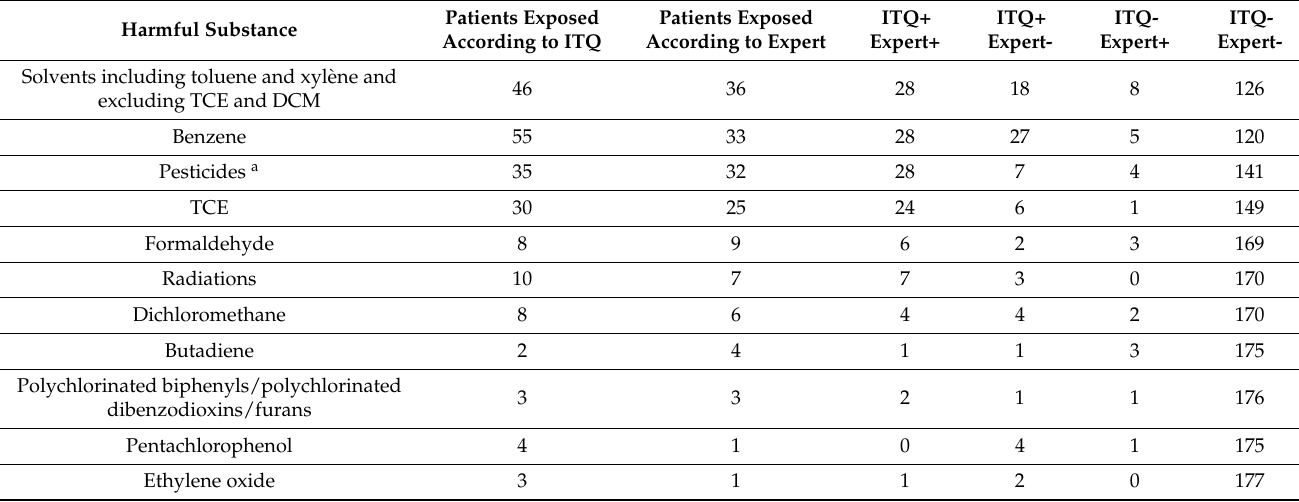
Table 4. Comparisons of the exposures according to ITQ and expert analysis in the “unfiltered” population ( n = 180). RHELYPRO Study